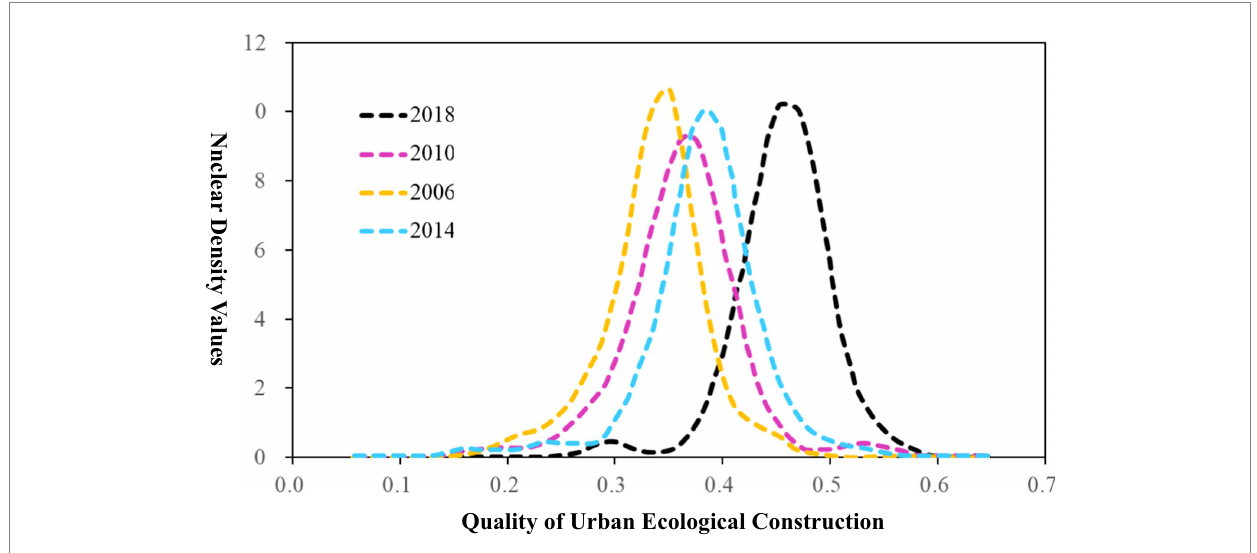
FIGURE 2 Kernel density estimation of quality of urban ecological construction in the Yellow River